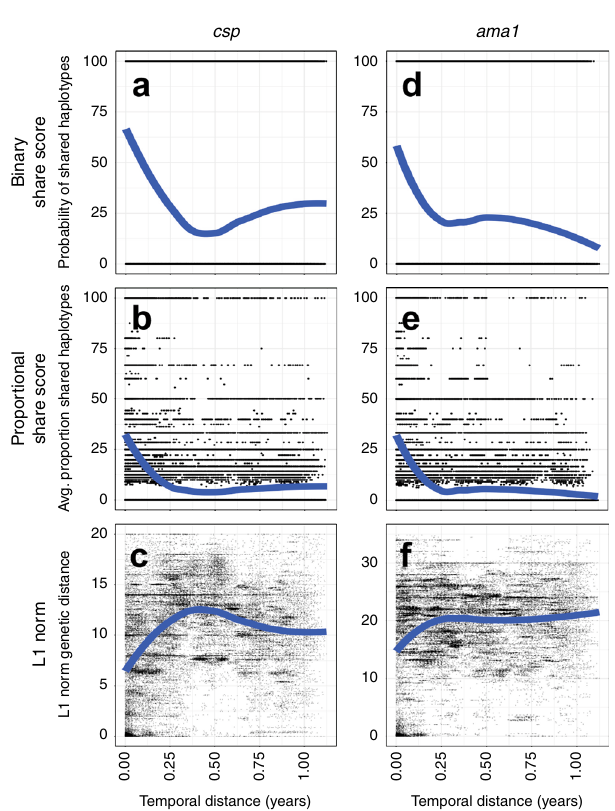
Fig. 5 Case children with temporally proximal infections have enhanced genetic similarity of csp/ama1 haplotypes. Genetic similarity metrics were computed for all possible pairings of case children for csp ( n = 273) and ama1 ( n = 288) haplotypes. a – c csp haplotype binary sharing ( a ), proportional sharing ( b ) and L1 norm ( c ) metrics for all CC pairwise comparisons is plotted against temporal distance for CC. d – f ama1 haplotype binary sharing ( d ), proportional sharing ( e ), and L1 norm ( f ) metrics for all CC pairings is plotted against temporal distance for CC. Blue lines indicate the locally estimated scatterplot smoothing (LOESS) regression fi t of